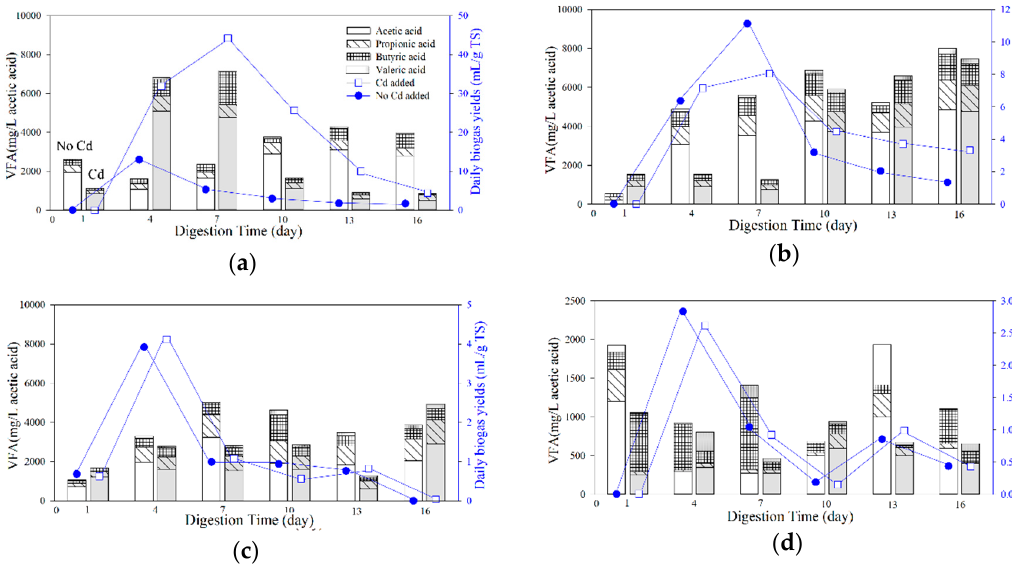
Figure 4. Volatile fatty acid (VFA) concentrations (as mg/L acetic acid) in the liquid phase with (right gray column) and without (left white column) Cd stress with digestion temperatures of 55 °C ( a ), 45 °C ( b ), 35 °C ( c ), and 25 °C ( d ). The compositions of VFA are shown by stacked bars with the order of acetic acid (blank), propionic acid (coarse), butyric acid (grid), and valeric acid (dotted) from bottom. Acetic acid was the main component of the VFA, followed by propionic acid ≈ butyric acid > valeric acid in the 55 °C, 45 °C, and 35 °C groups. When the digestion temperature was 25 °C, the percentages of butyric acid and valeric acid increased at various time intervals in the no Cd-added group, as well as the first day of the Cd-added group. The concentrations of butyric acid were even higher than the concentrations of acetic acid sometimes. Therefore, low temperature was not beneficial for the generation of acetic acid or transforming high VFAs (butyric acid and valeric acid) into low VFAs (acetic acid), especially in the no Cd-added group. It was, thus, proposed that the reaction rate of generating acetate from glucose (Equation (1)) or acetogenesis from butyric acid